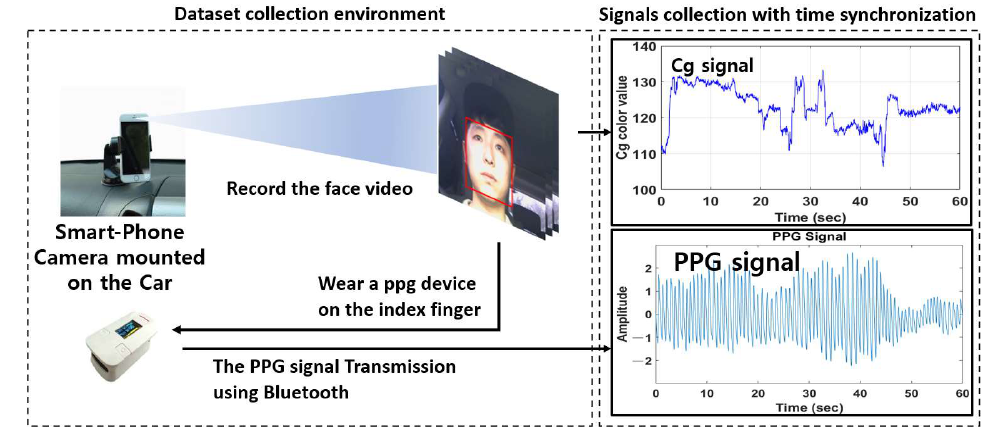
Figure 18. Dataset collection environment when driving a car.